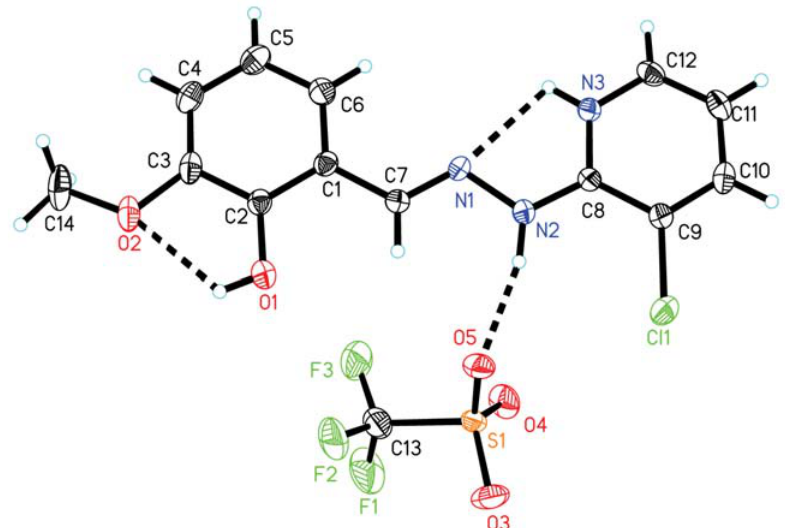
Figure 3. Crystal structure of 1 . Displacement is drawn at the 30% probability level. Hydrogen bonds are shown as dashed lines.